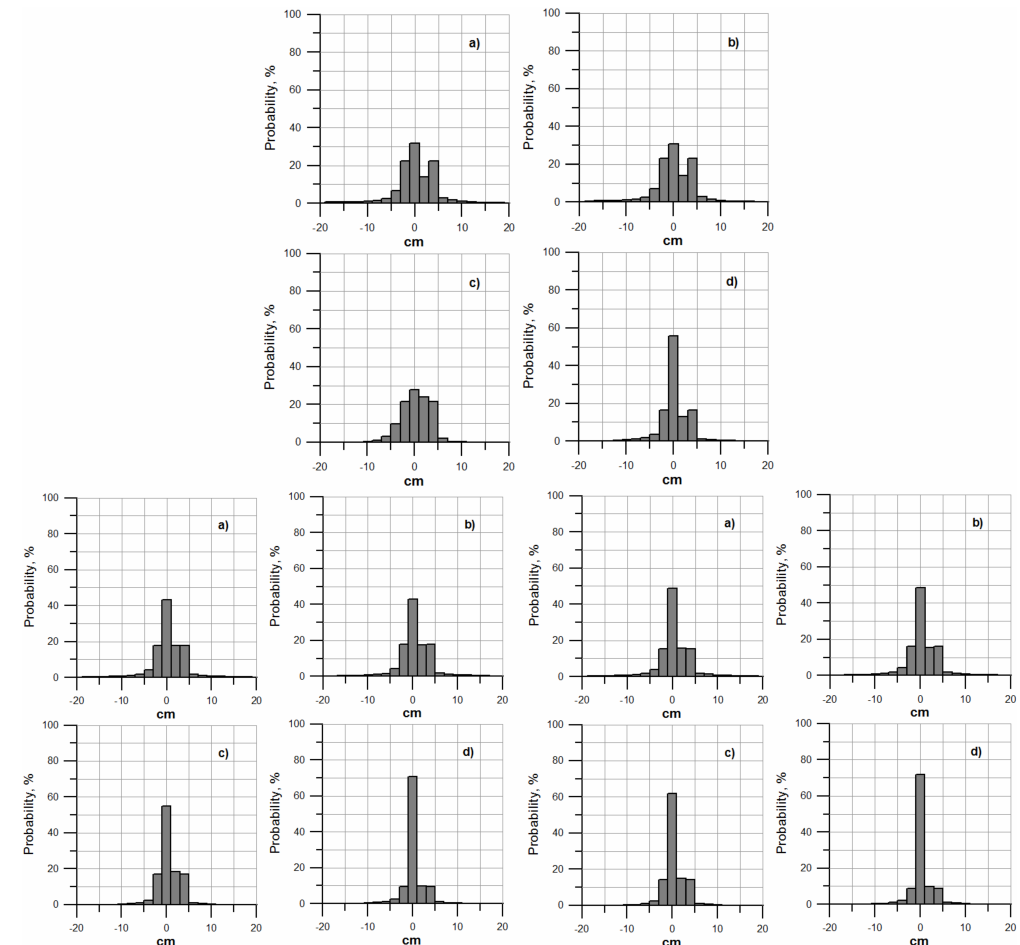
Figure 16. Histograms of the difference between solutions at different mesh resolutions: (top) sea-surface elevation; (bottom left) the u -component of velocity; and (bottom right) the v -component of velocity. ( a ) Meshes m8 and m5 (“weak wind”); ( b ) Meshes m8 and m5 (“strong wind”); ( c ) Meshes m5 and m3 (“weak wind”); and ( d ) Meshes m5 and m3 (“strong